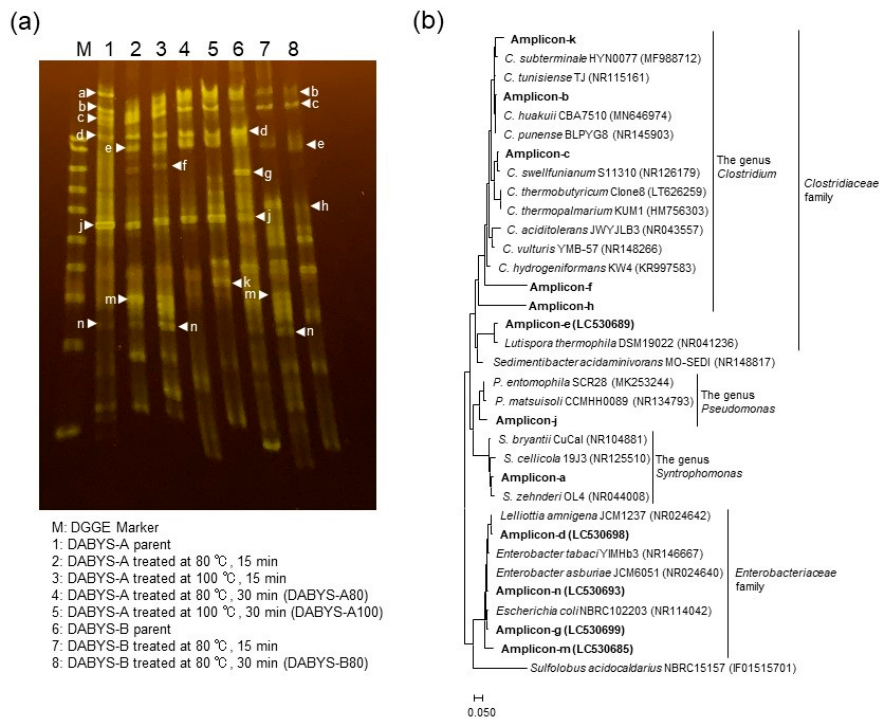
Figure 4. ( a ) Denaturing gradient gel electrophoresis (DGGE) band patterns of the heat-treated DABYS microflorae. ( b ) A phylogenetic tree based on the V6–V8 region of the 16S rRNA genes of the microflora member strains.